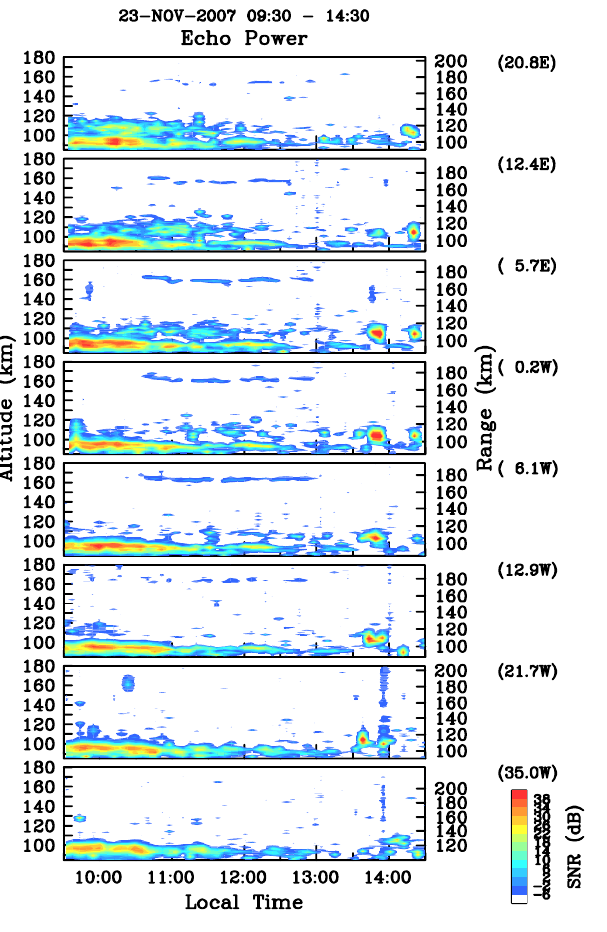
Fig. 6. Maximum SNR of (a) 150-km, (b) upper E-region, and (c) lower E-region echoes averaged for 13 days during the normal mode observation. Beam directions are represented by different colors.